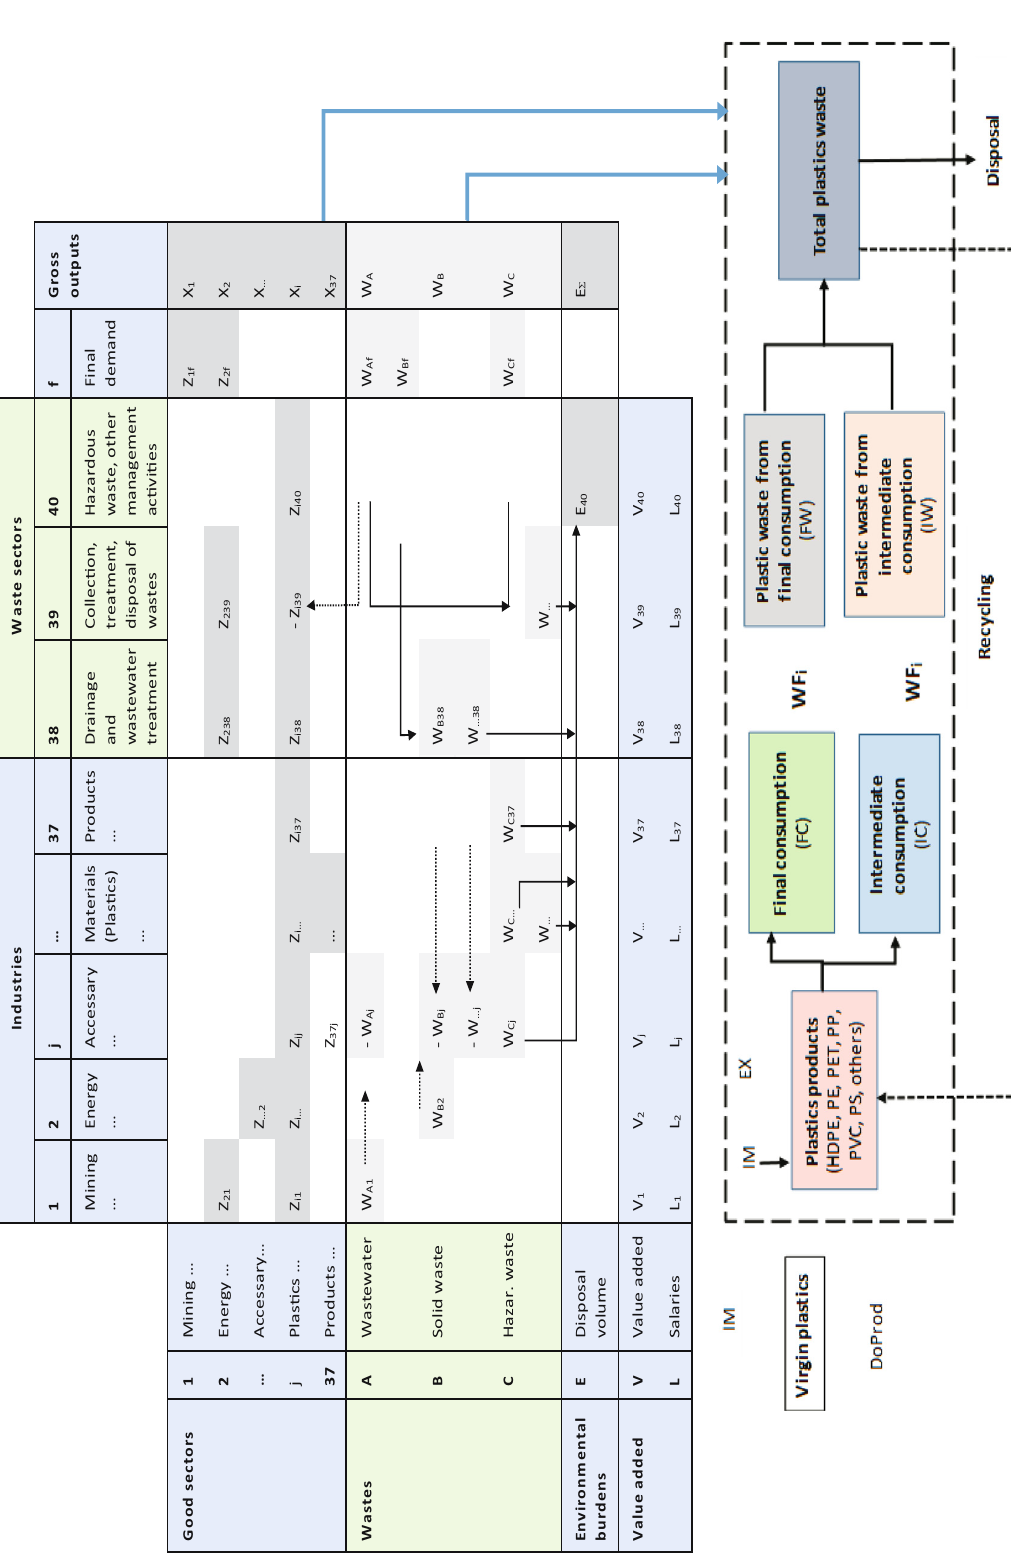
Figure 1: Research